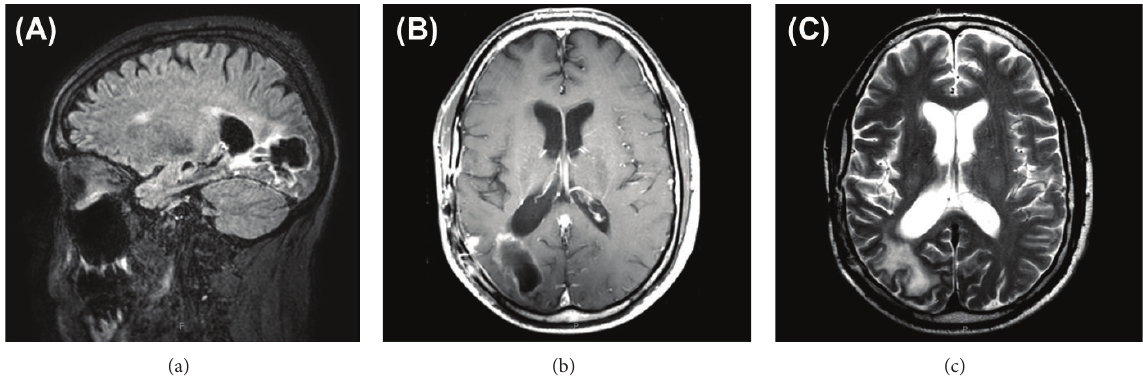
Figure 3: Intracranial imaging during final course of salvage therapy with bevacizumab and carboplatin. (a) FLAIR, (b) T1-weighted axial, and (c) T2-weighted axial magnetic resonance imaging demonstrating stable intracranial disease at time of respiratory decline. Postsurgical hyperintensity surrounds area of resection in the right temporal and occipital lobes communicating with the right occipital horn, unchanged with respect to prior